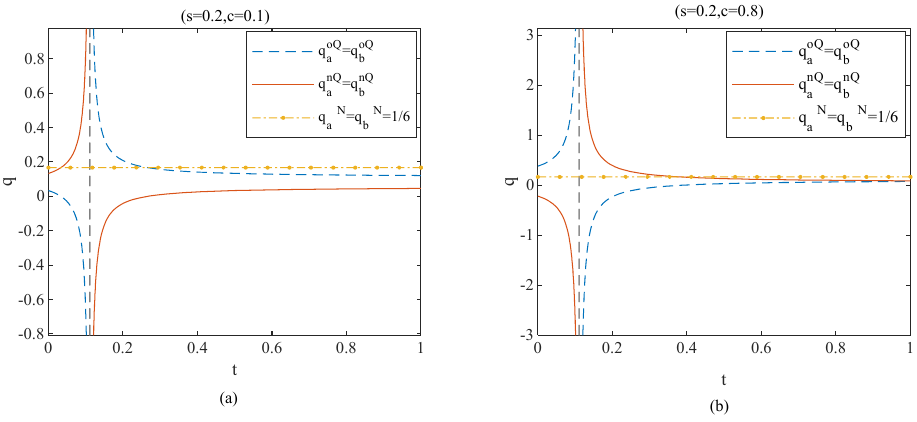
Figure 4. Quality set by platforms in period 2 in equilibrium ( c = 0.1 vs. c = 0.8).